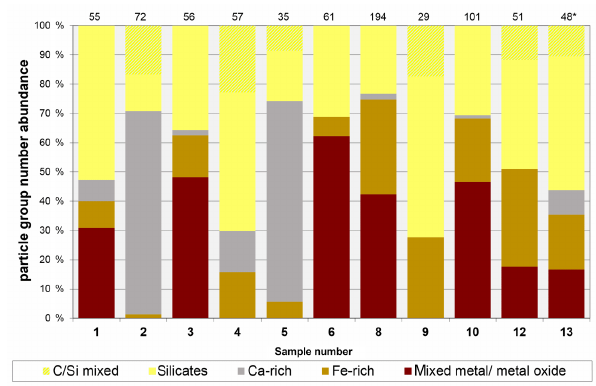
Figure 8. Particle group number abundance (PGNA) within 11 sam- ples collected during RECONCILE flights. PGNA refers to refrac- tory particles larger than 500nm ( ∗ the number of analyzed particles is shown above each column).